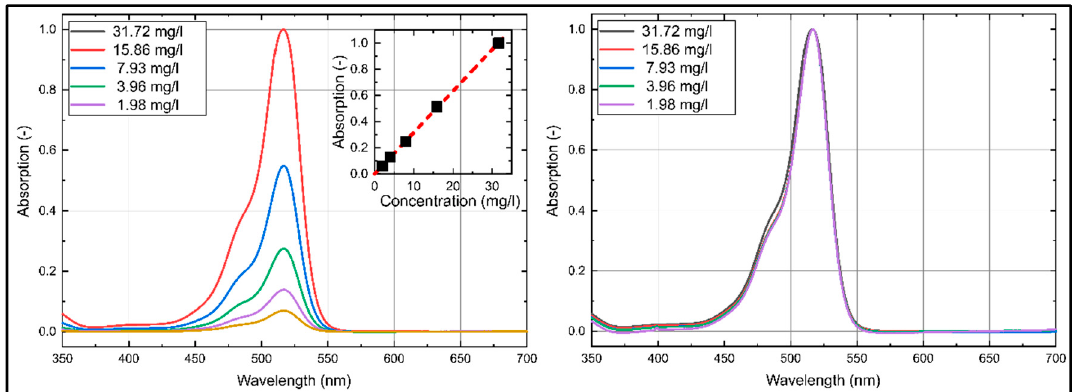
Figure 5. Absorption spectra ( left : normalized to maximum intensity of 31.72 mg/L; right : normalized to the respective maximum intensity) of Eosin-Y dissolved in water, inserted diagram show linearity ( R 2 = 0.999) of the integral LIF-signal for various dye concentrations; 293 K, 0.1 MPa.